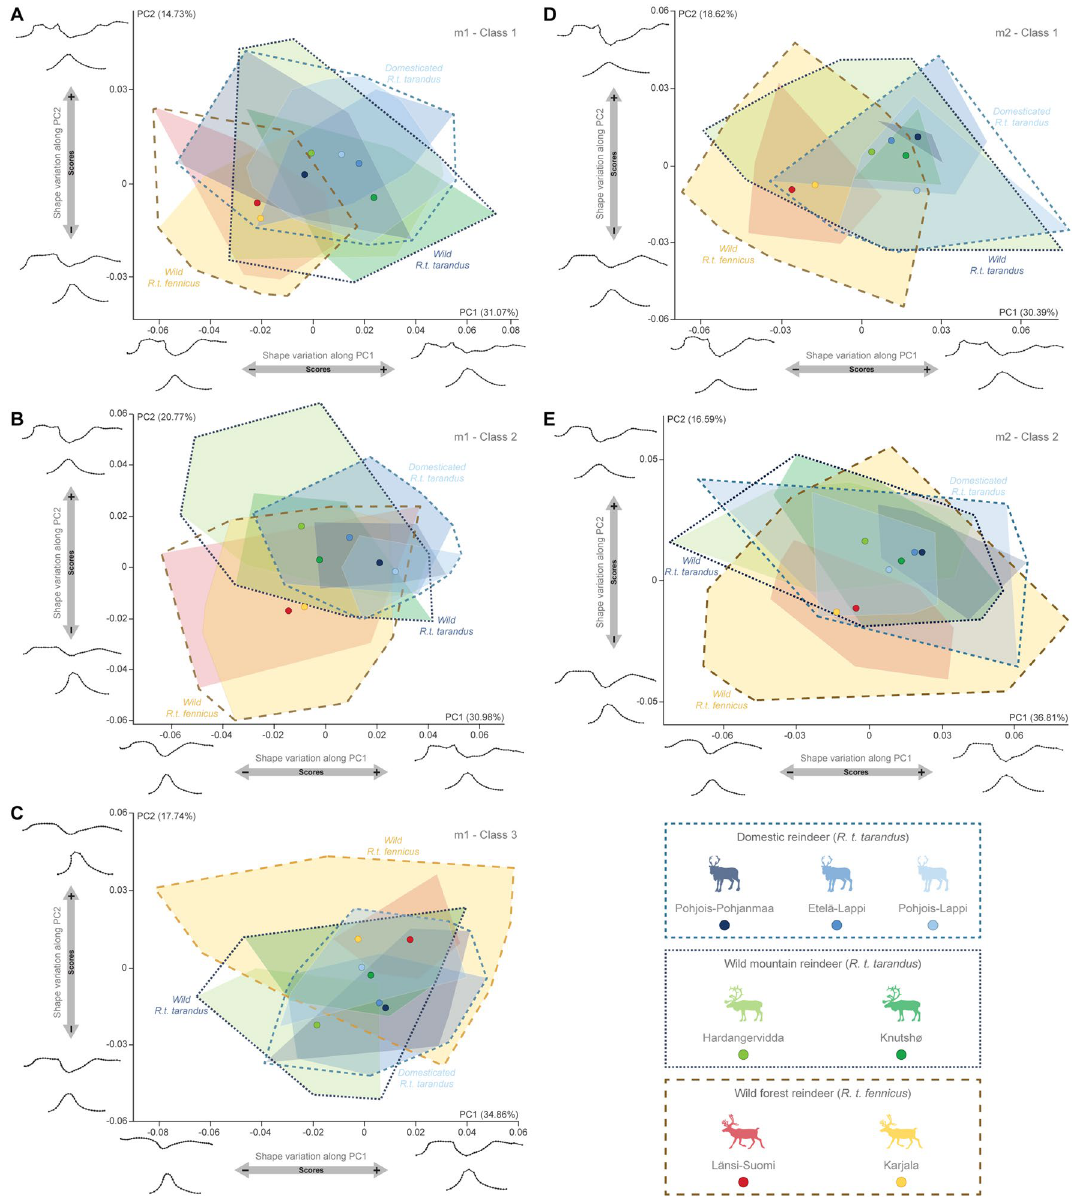
Figure 3. Scatter plots of the two first axes (PC1 and PC2) of principal component analyses performed on the shape data according to the population for m1-Class1 ( A ), m1-Class2 ( B ), m1-Class3 ( C ), m2-Class1 ( D ) and m2-Class2 ( E ) and visualization of shape variation via deformation of the mean shape along negative and positive PC1 and PC2 values. Each circle corresponds to the mean value of a population. The proportion of the total variance respectively expressed by the axes PC1 and PC2 is indicated in